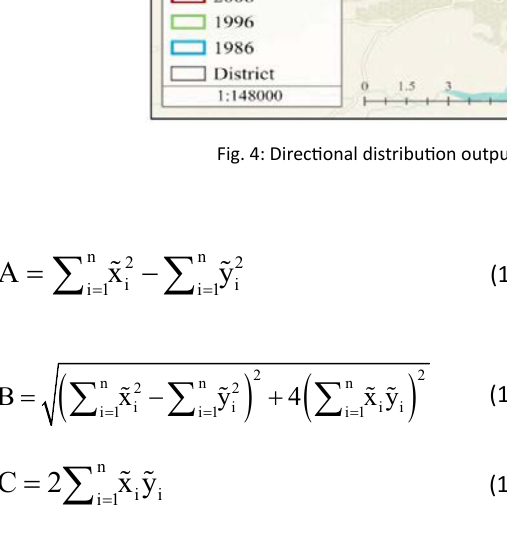
Table 7 indicates a moderately rising trend in the population of Mashhad from 1463500 to 3001184 people in 1986 and 2016 successively. Considering